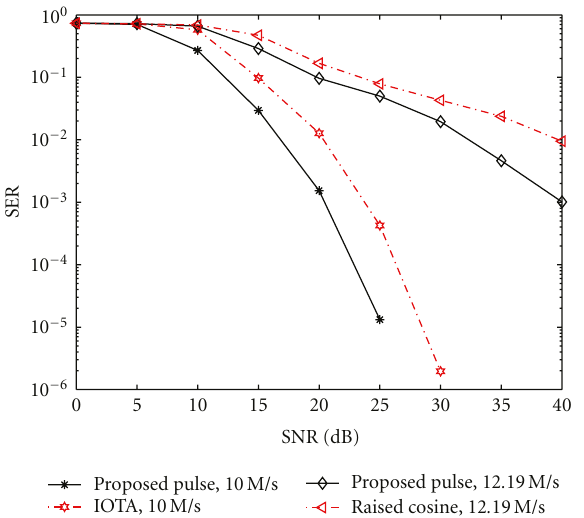
Figure 11: SER performance comparison for random delay only at di ff erent symbol rates, with CFOs randomly chosen within the range [0,0 . 001 /T s ].